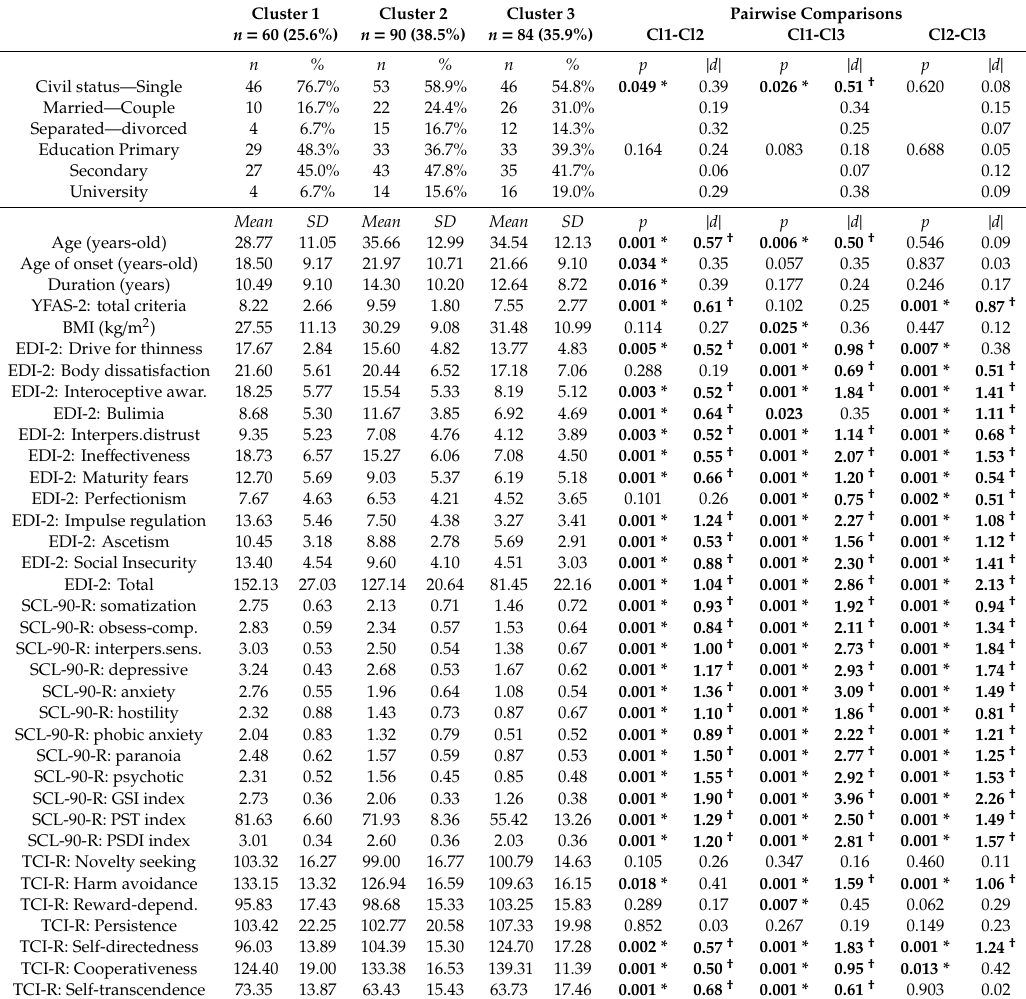
Table 1. Comparison between clusters for variables of the